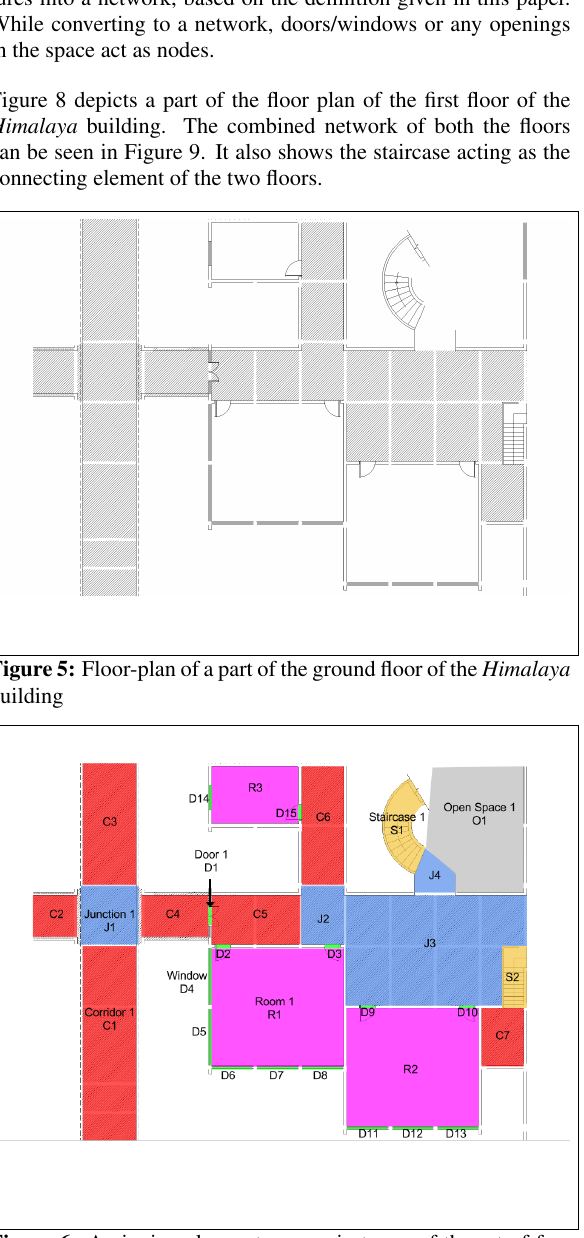
Figure 6: Assigning classes to space in terms of the set of fea-